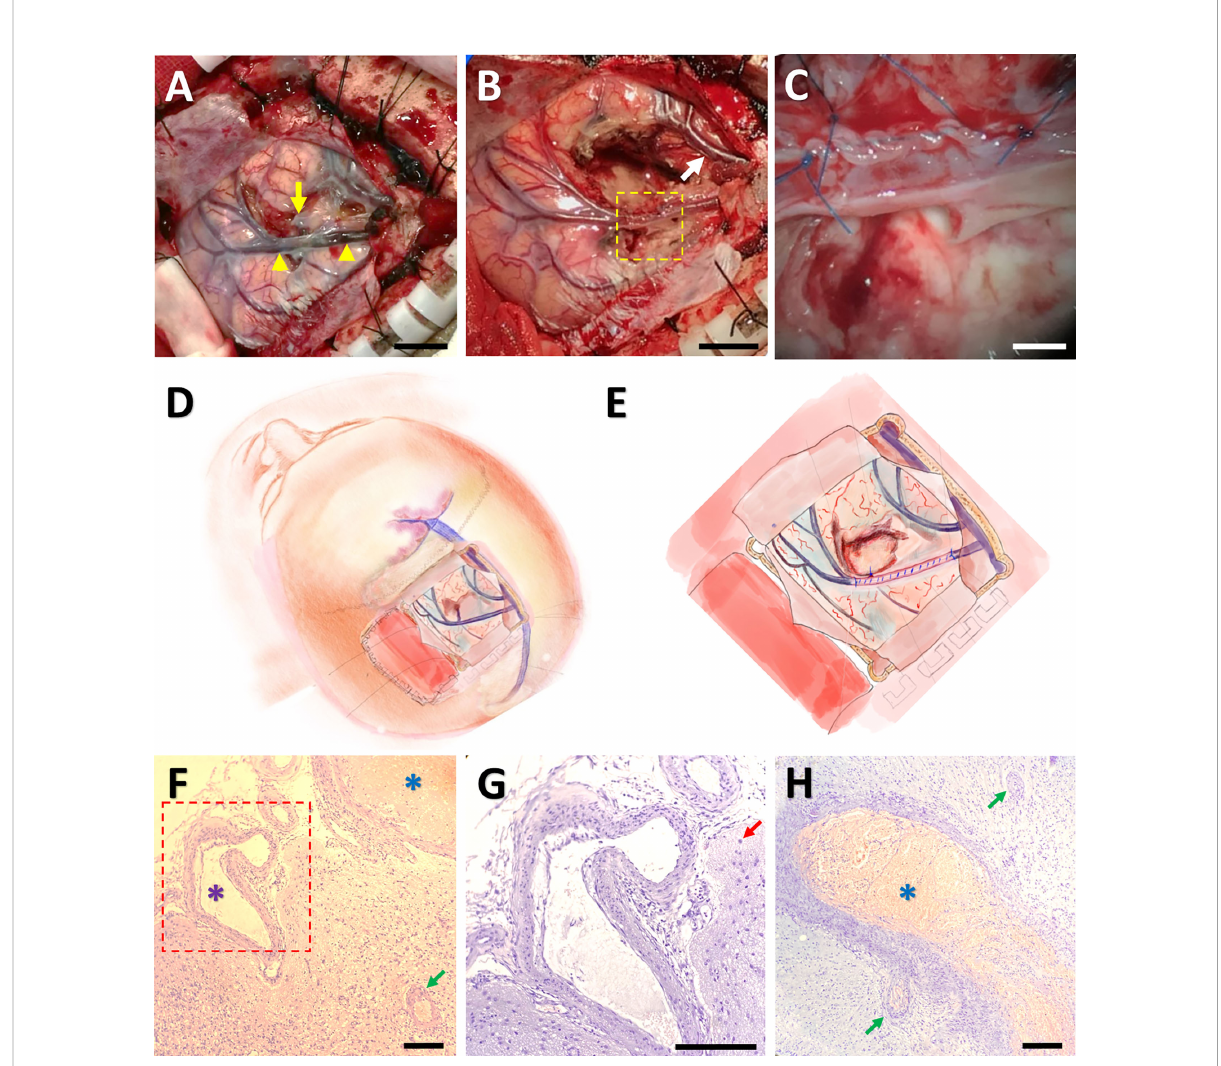
FIGURE 3 Surgical thrombectomy and pathological con fi rmation of ICVT. An intraoperative image showing that the cortical vein (indicated by yellow arrowheads) as well as its deep branch (the yellow arrow) became darkened and stiff. The arrowheads denoted the starting and ending points of the thrombosis (A) . After surgical thrombectomy, both the occluded vein and an adjacent cortical vein (the white arrow) returned to normal color (B) . The framed area in (B) was magni fi ed in (C) , indicating suture of the vein after thrombus removal. Bars = 1 cm in (A, B) , and 200 mm in (C) The operation approach (D) and surgical thrombectomy (E) were further illustrated by cartoon images. Hematoxylin-eosin staining under light microscopy showed thrombosis in some venules (blue arterisks), vascular malformation (the purple arterisk) and proliferation (green arrows), and gliosis (the red arrow) (F-H) . The framed area in (F) was magni fi ed in (G) . Bars = 50 m m in (F-H)